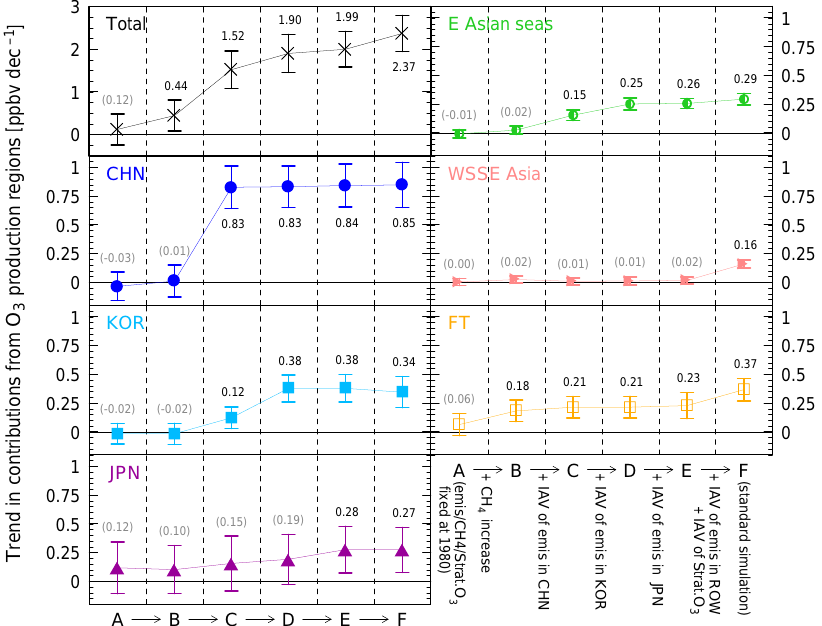
Figure 9. Linear trends in the annual mean contributions in 1980–2005 from source regions to surface O 3 over Japan in the sensitivity simulations and the standard simulation (error bars are 95% confidence intervals). The exact values of the trends are also shown in the figure; the trends without sufficient statistical significance are shown in parentheses. The trends in each region’s contribution in the simulations A–E and F (the standard simulation) are arranged from left to right in each